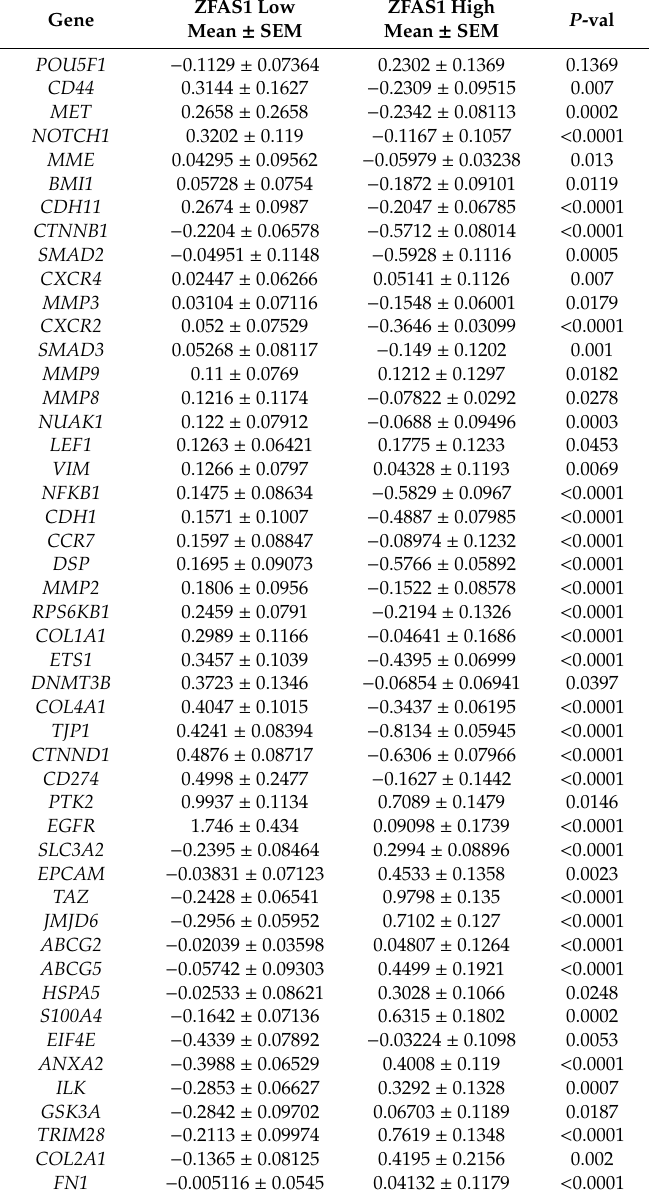
Table 4. Di ff erentially expressed genes connected with the EMT process, the metastasis process, and cancer-initiating cell maintenance in the group of patients with low and high expression of ZFAS1 ; p < 0.05 considered as